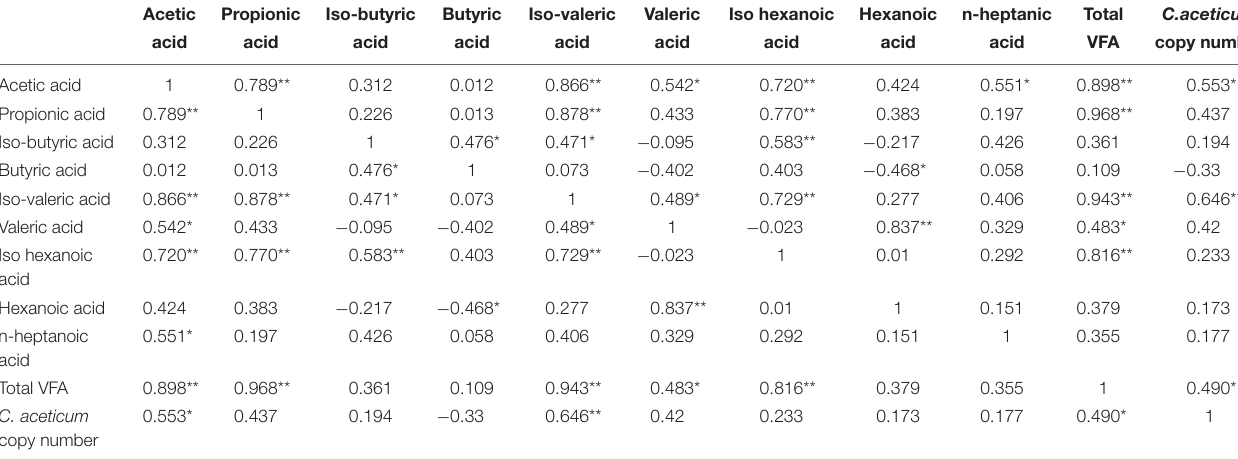
TABLE 2 | Correlation coefficients between the quantification of C. aceticum with VFA composition after bioaugmentation. Acetic Propionic Iso-butyric Butyric Iso-valeric Valeric Iso hexanoic Hexanoic n-heptanic